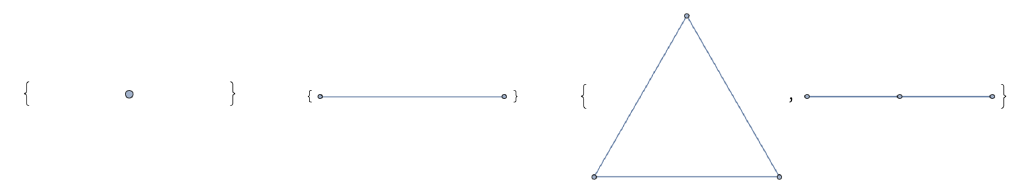
(left), Q [2] (middle), and Q [2] 1 2